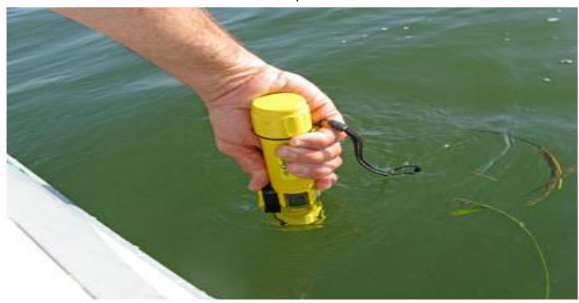
Figure. 2. Example of using depth sounder method ( Irons, 2013 ).